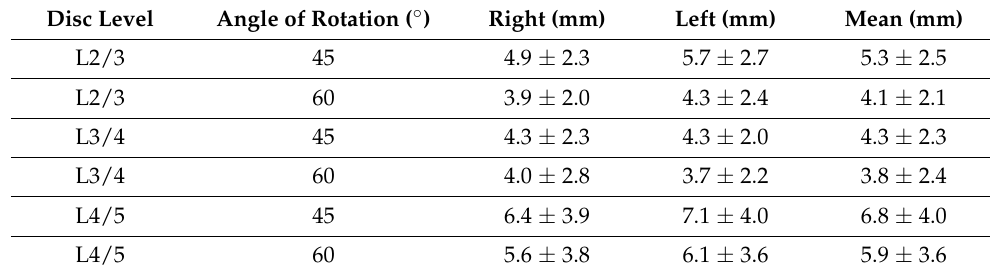
Table 2. Superior articular process for the exiting nerve distance. Disc Level Angle of Rotation (°)